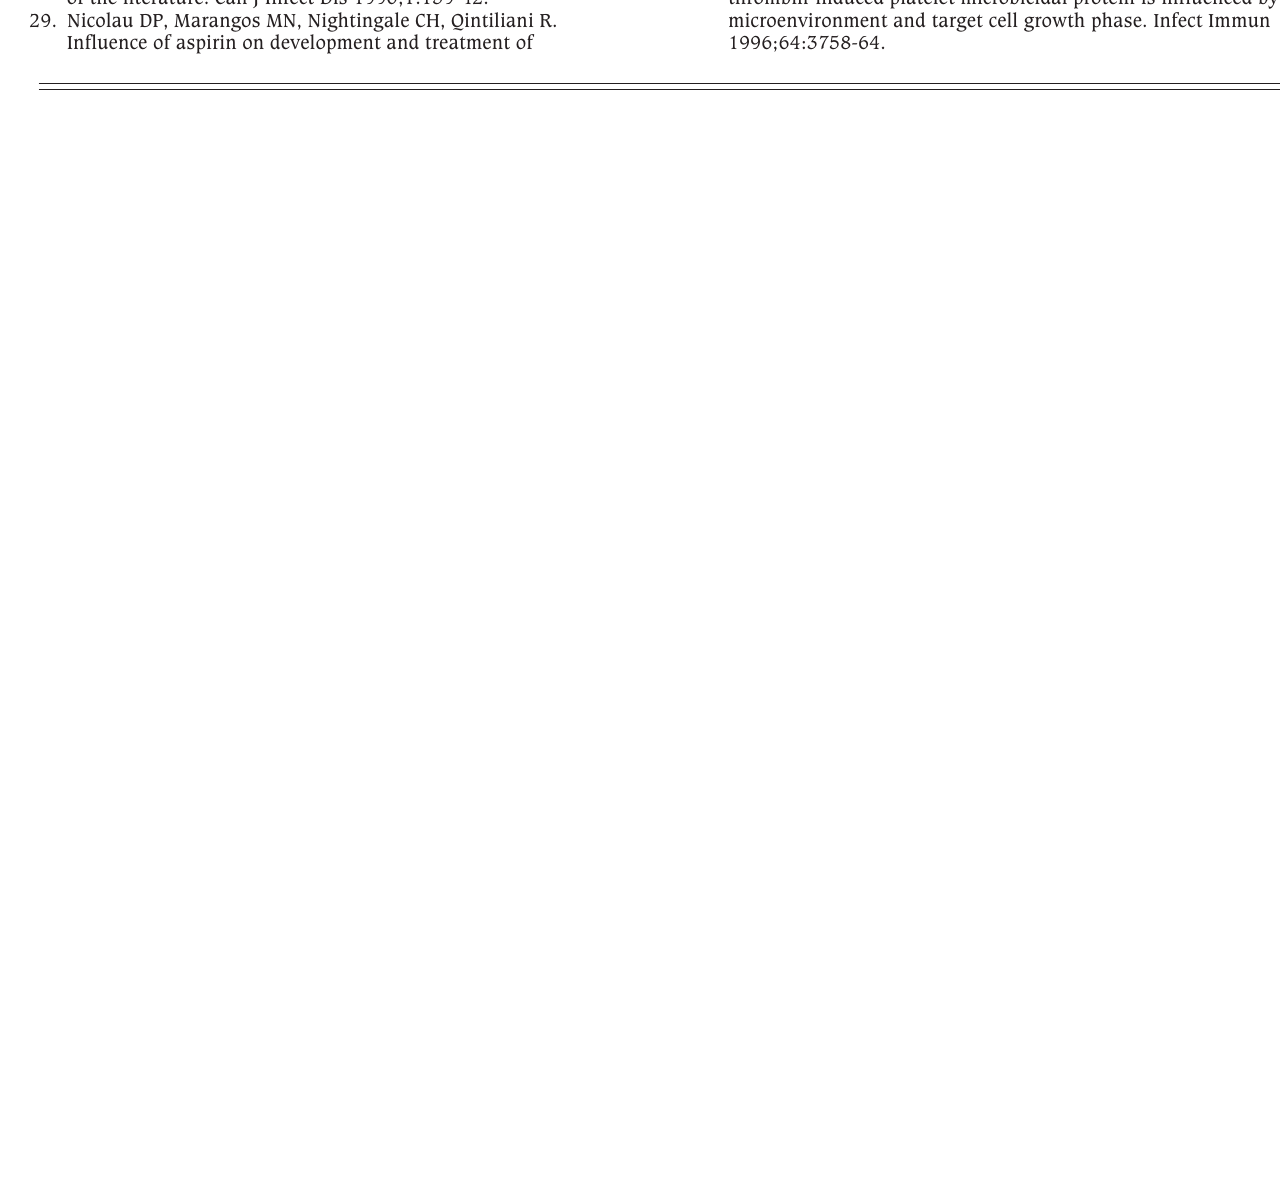
on natural history of right-sided streptococcal endocarditis in rabbits: role for cellular host defenses. Infect Immun 1982;35:320-5. 28. Patrick WD, Brown WD, Art M, Bowmer I, Sinave CP. Infective endocarditis due to Eikenella corrodens ; case report and review of the literature. Can J Infect Dis 1990;1:139-42. 29. Nicolau DP, Marangos MN, Nightingale CH, Qintiliani R. Influence of aspirin on development and treatment